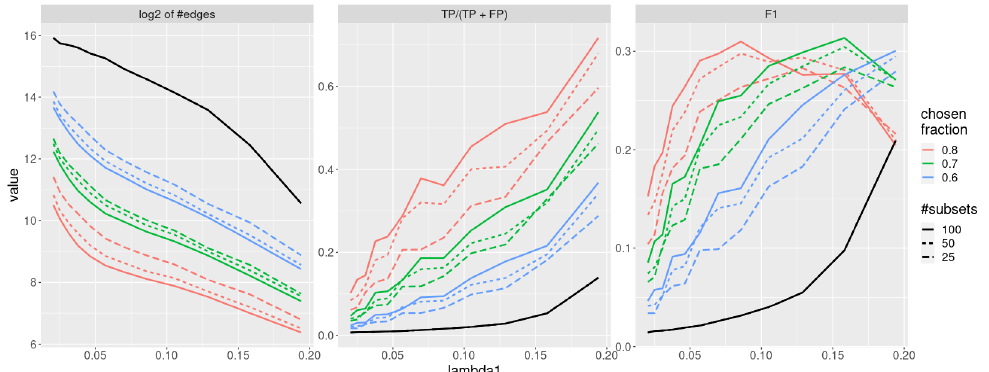
Figure 6. Performance of the jewel 2.0 method applied to K = 3 datasets of the size p = 500, n k = 100, ( k ) = 1. The solid black line denotes performance without m = 1, power = 1, all weights are set W ij stability procedure. Colour denotes a varying threshold of % of subsets in which edge needs to be present to be chosen. Line-type denotes a varying number of subsets. Left panel : log 2 of the order of the graphs. Middle panel : precision. Right panel : F1-score.